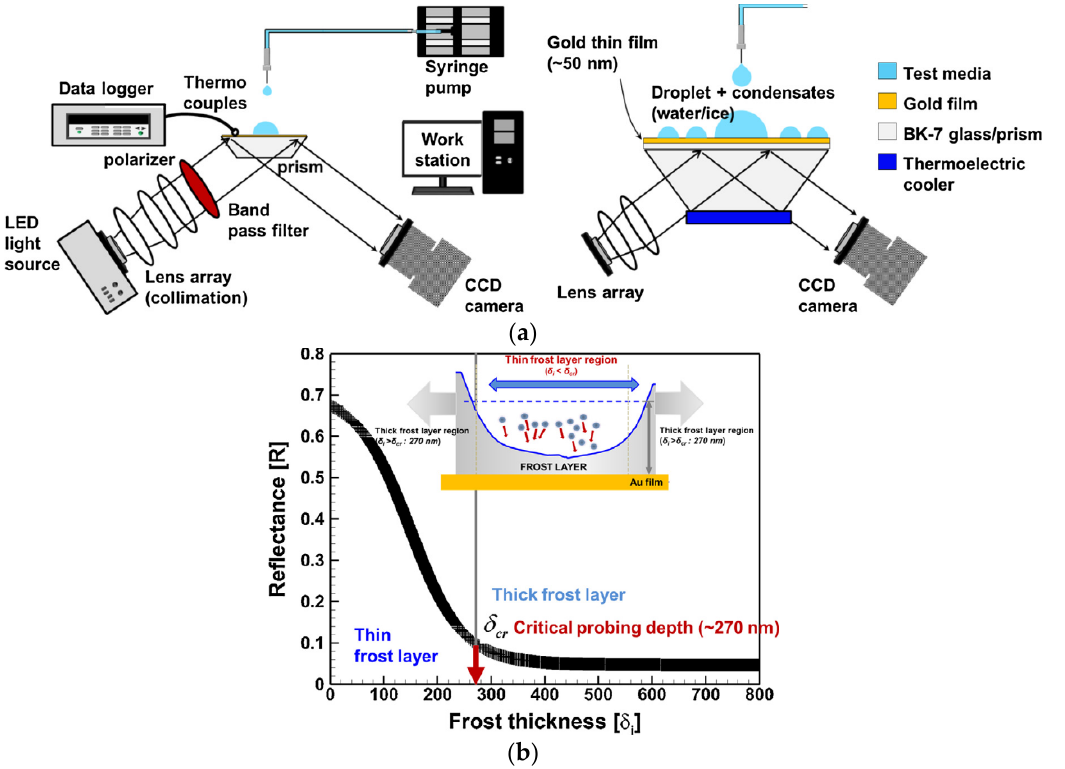
Figure 9. Surface plasmon resonance (SPR) detection: ( a ) a schematic diagram of the SPR imaging setup used in this research; ( b ) reflectance curve regarding changes in frost layer thickness in the air.